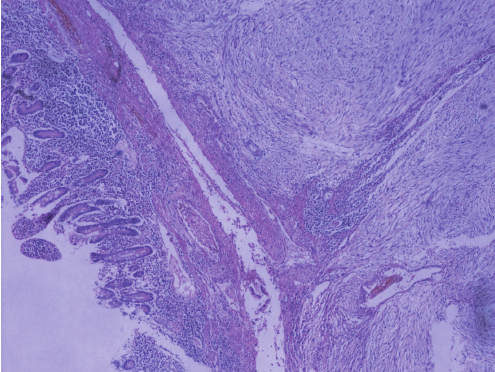
Figure 2: Photomicrograph (IHC stain; original magnification × 400) of immunohistochemical study showing tumor cells positive for KIT (CD117).